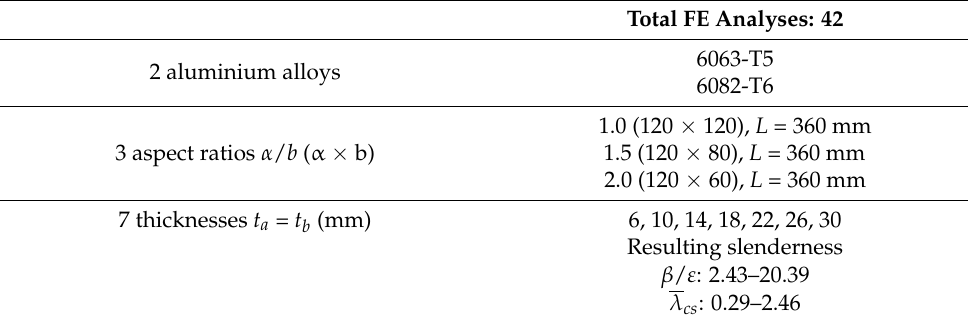
Table 3. List of examined parameters in parametric studies.